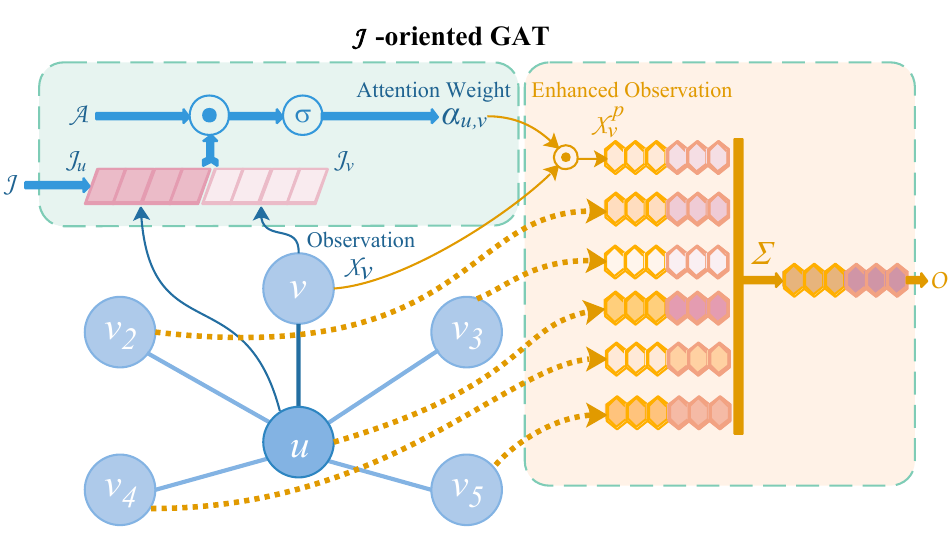
Figure 5. The architecture of J -oriented graph attention layer. In the time-oriented graph atten- tion layer, it is assumed that [ J , J u , J v , O ] is the time-encoding feature vector [ p , p u , p v , T ] , while in the location-oriented graph attention layer, we assume [ J , J u , J v , O ] to be the location-embedding representation [ l emb , l emb u , l emb v , L ]